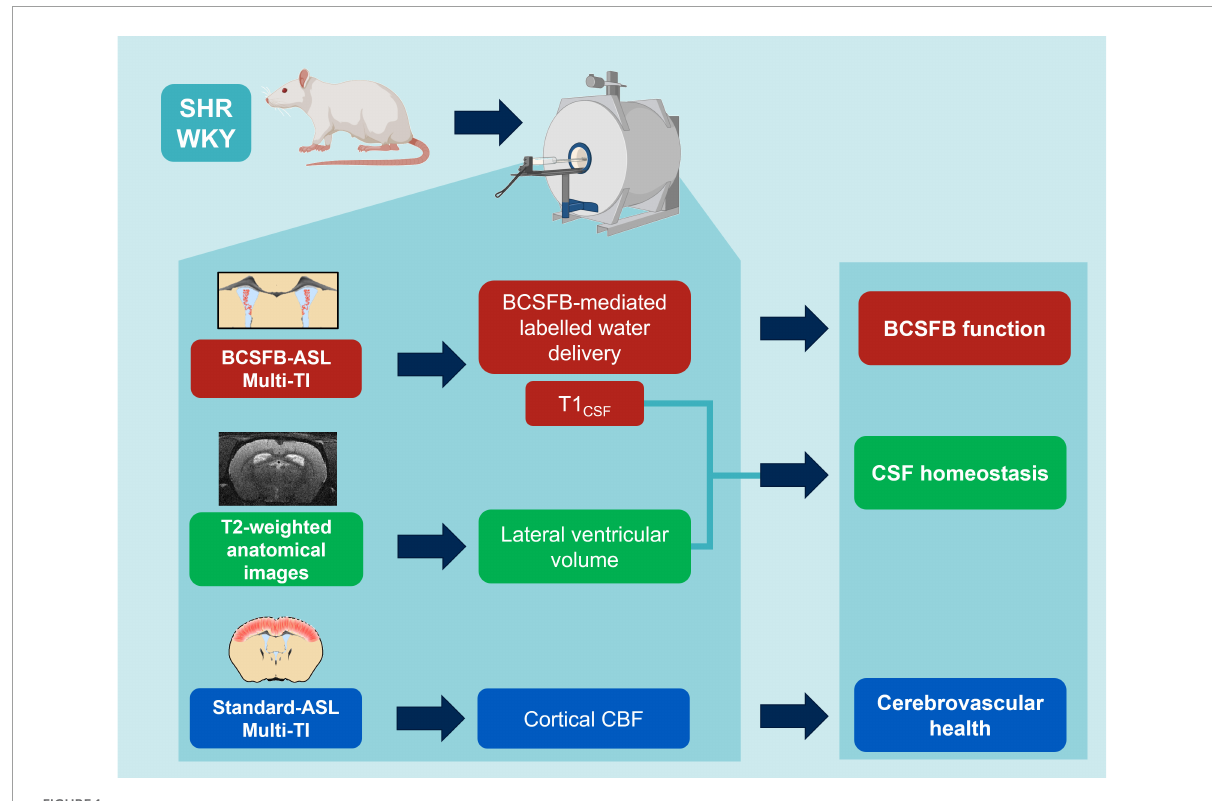
FIGURE1 MRI protocols: non-invasive multi-inflow time (multi-TI) arterial spin labeling (ASL) and structural, T2-weighted MRI to inform on hypertension-induced impairment of BCSFB function, CSF homeostasis and cerebrovascular health (created with Biorender.com).